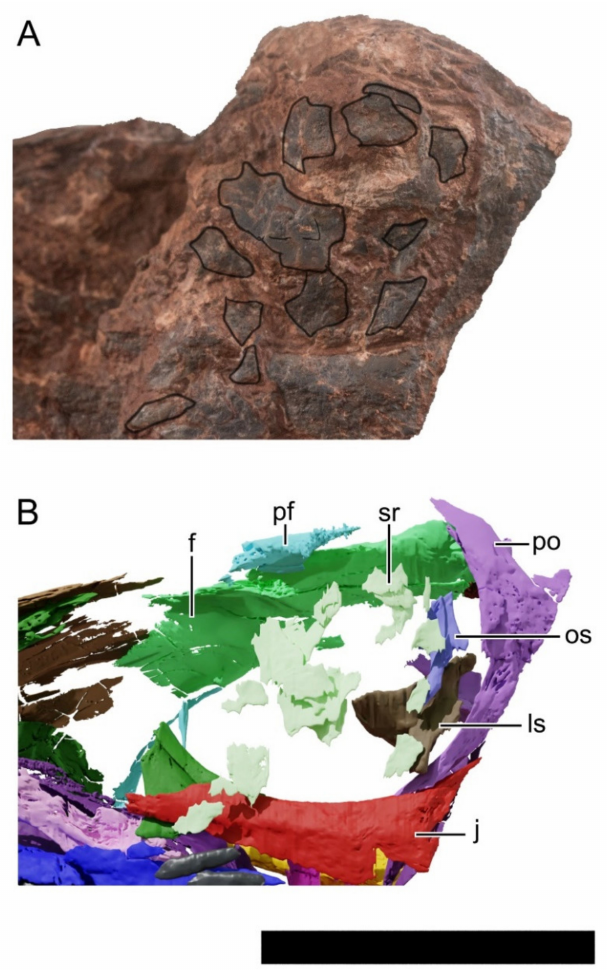
Figure 35. Photograph and digital reconstruction of the left orbital region of NHMD 164758. ( A ) Pho- tograph of the left orbital region of NHMD 164758. ( B ) Digital reconstruction of the left orbital region of NHMD 164758. Scale bar = 50